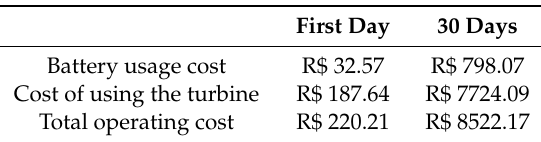
Table 5. Operating data for scenario